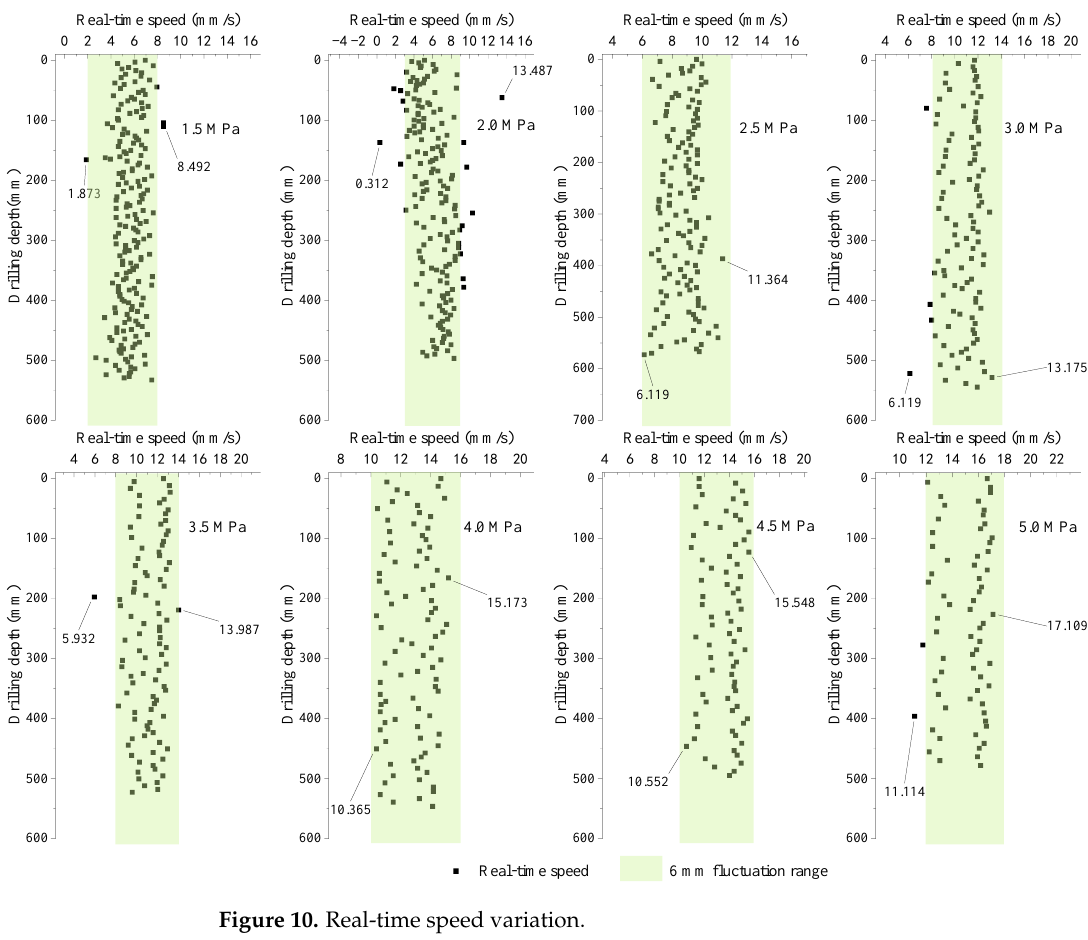
Figure 10. Real-time speed variation.